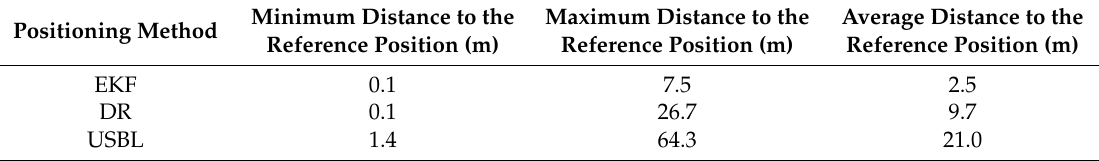
Table 6. Statistical parameters of positioning errors using EKF and DR methods and the USBL system (single passage).